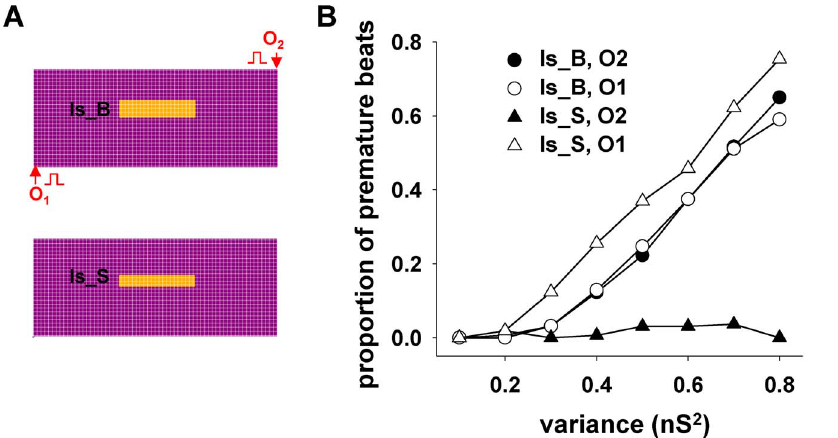
Figure 6. The generation of premature beats may depend on the direction of signal propagation. A) schematic representation of the two ischemic areas investigated, and the two stimulation points (O1 and O2) used to model different directions for the propagation of a physiological signal; B) Proportion of premature beats as function of the variance of the gap junction conductance inside the ischemic area for different stimulation points. The average value of the gap junction conductance of the cells inside the ischemic area was 4.7 nS in all cases.